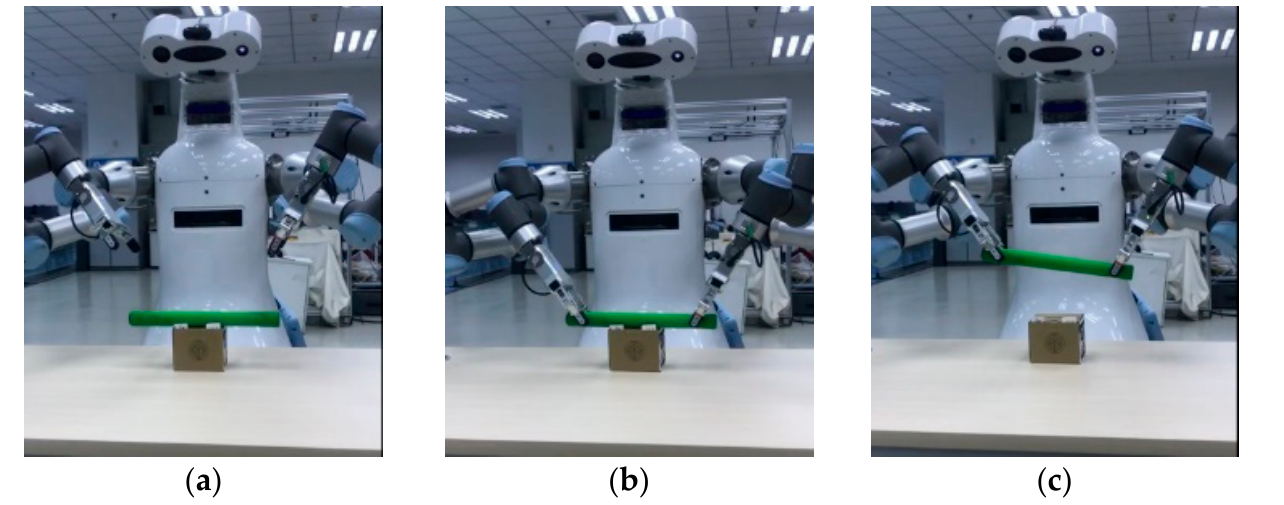
Figure 13. ( a – c ) The process of physical robot completes the grasping task.